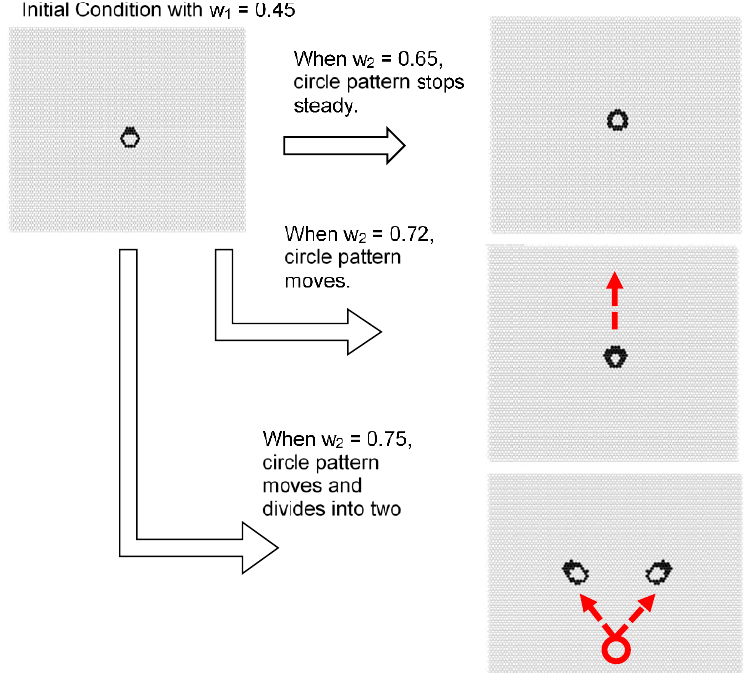
Figure 19. Possibility of self-organized ring patterns with one parameter. The results are a part of the model with s = 5 and s = 8 in a hexagonal grid, as shown in Figure 13. The ring pattern can be controlled with parameter w 2 . When w 2 = 0.65, the ring pattern was divided while moving. When w 2 = 0.72, a moving ring pattern formed. When w 2 = 0.75, a fixed ring pattern formed.